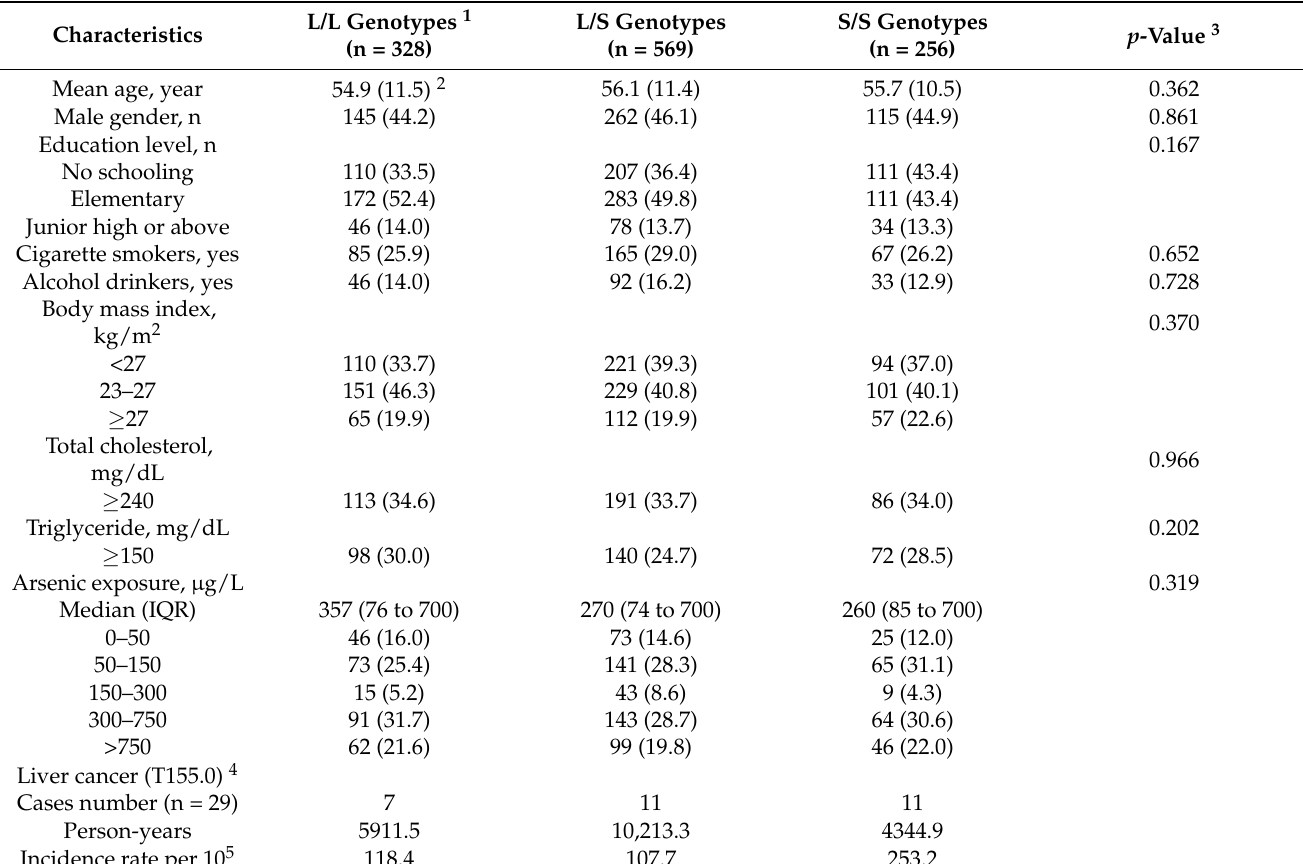
Table 1. Baseline characteristics and incidence of liver cancer during follow-up according to HO-1 promoter genotype among 1153 study subjects, 1989–2013.